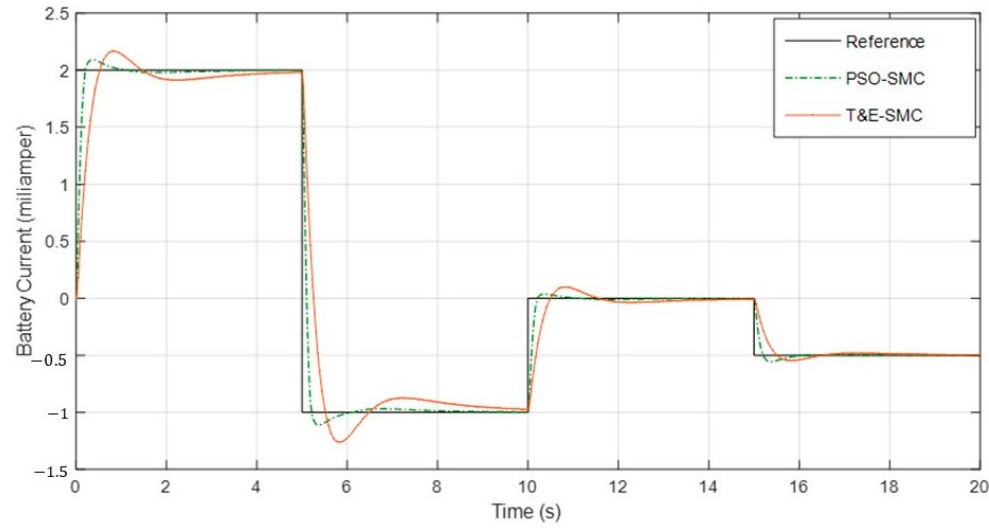
Figure 11. Battery current based on the scenarios in Table 1. Table 2. Cost function and changes in battery charge status in different control systems.